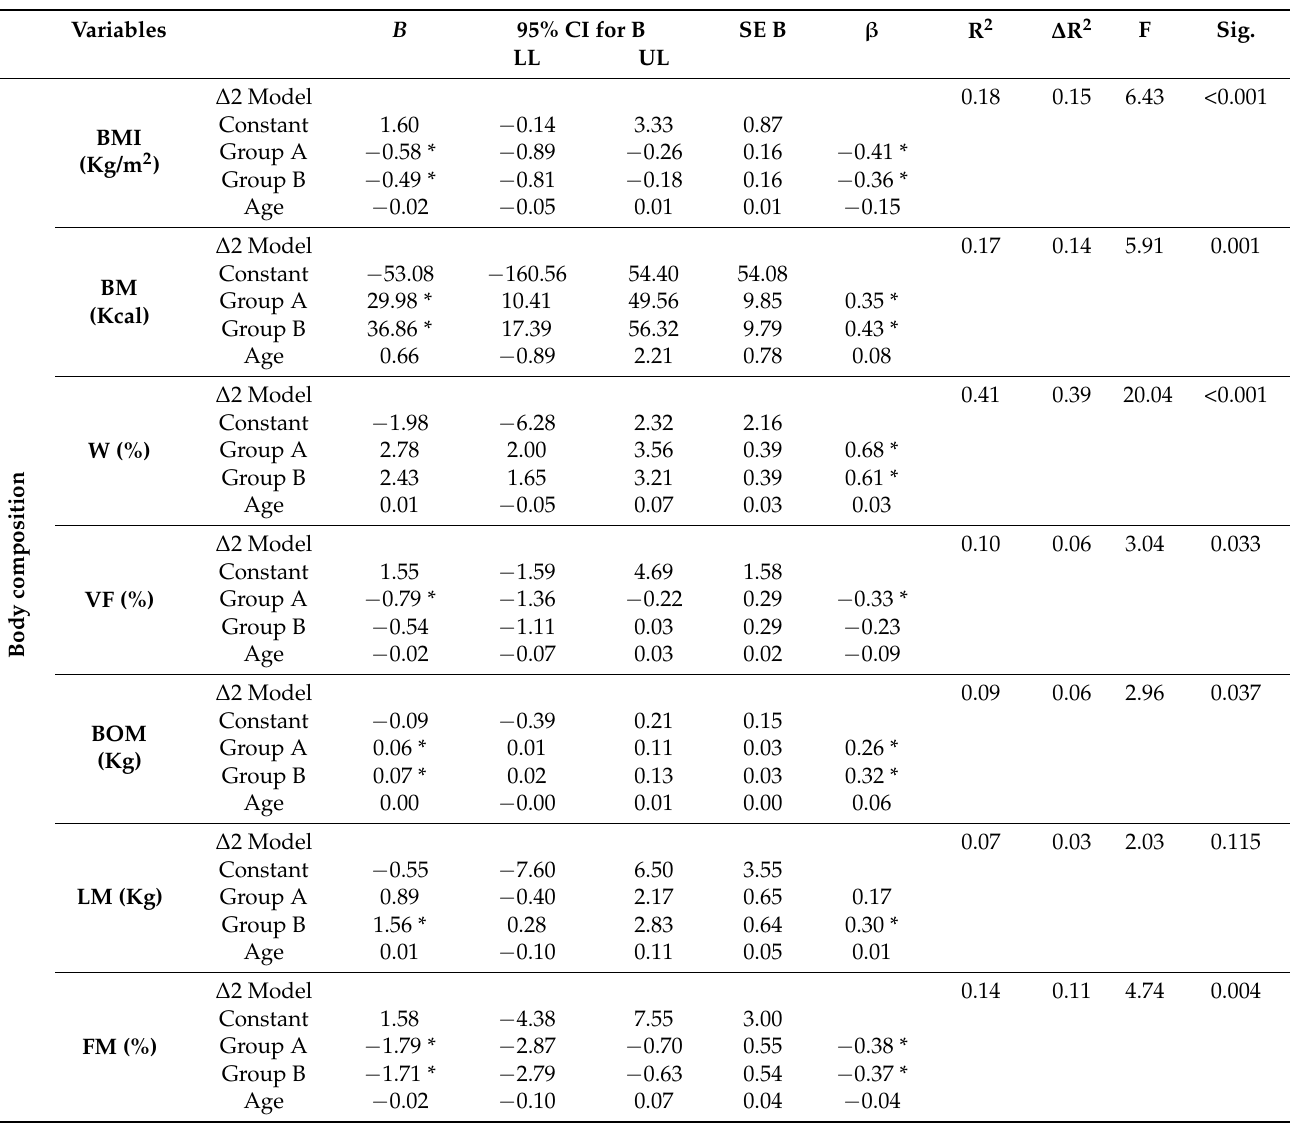
Table 3. Multiple regression results for the significant variations between the first and third moments of evaluation ( ∆ 2) and between the first and second moments of evaluation ( ∆ 1), adjusted for the confounding factor